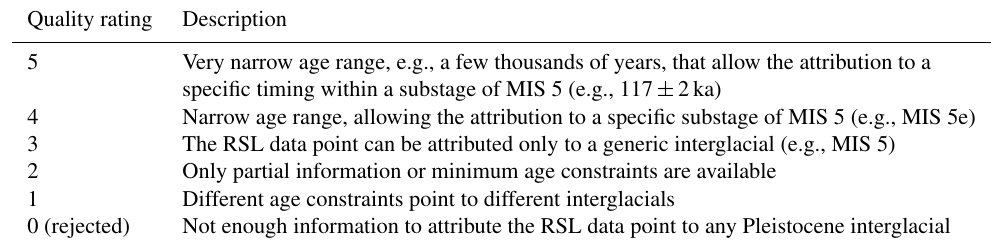
Table 2. Quality assessment of the relative sea-level data in terms of age uncertainty, as defined in the WALIS database documentation: https://walis-help.readthedocs.io/en/latest/RSL_data.html#quality (last access: 29 April 2022). Quality